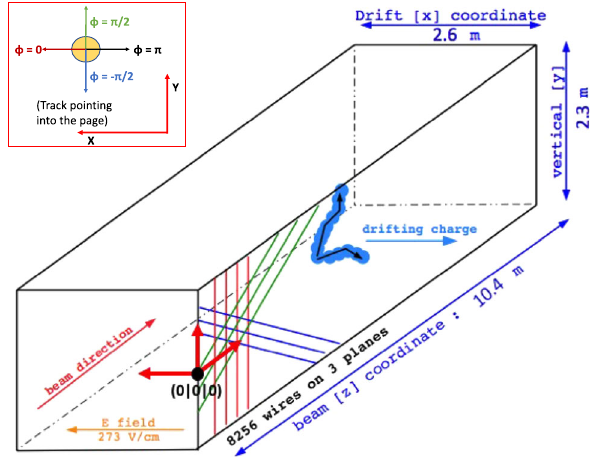
Fig. 2 A schematic of the MicroBooNE TPC showing the coordinate system and wire planes